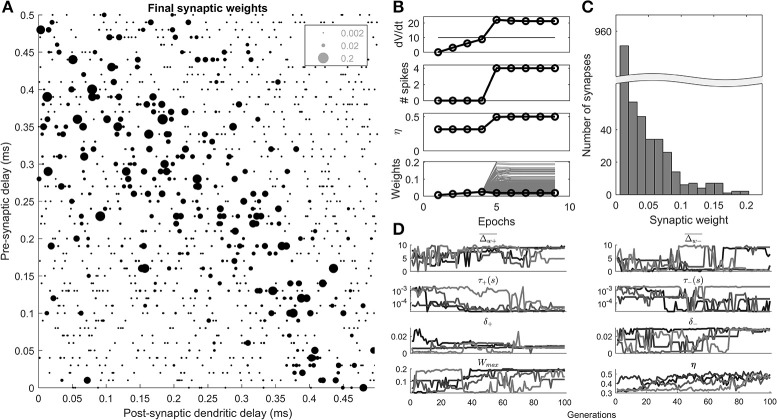
Results of the STDP learning rule, and genetic search. (A) An example cell's final synaptic weights shown as a function of their pre-synaptic and post-synaptic delays. (B) An example of the results of a 100th generation cell, during 10 epochs of learning. The maximum rate of change in voltage (dV/dt), number of spikes, η, the synaptic weights (gray), and mean synaptic weights (black) are shown as a function of 10 epochs of learning. (C) The distribution of the final synaptic weights. (D) The genetic algorithm results of 4 separate parameter explorations as a function of the search generation.